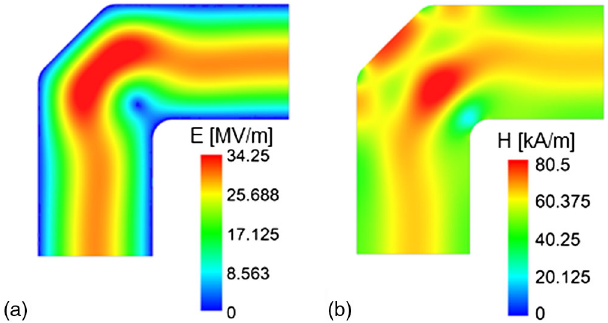
FIG. 6. H-plane miter bend for feeding thewaveguide coupler of the deflector, fields normalized to 100 MW of transmitted power: (a) surface electric fields with maximum value of 34 . 3 MV = m; (b) surface magnetic fields with maximum value of 80 . 5 kA = m.